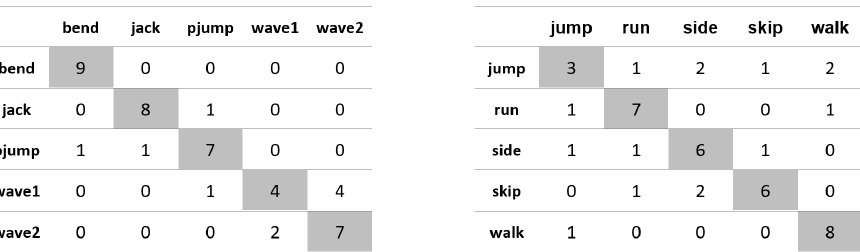
Figure A8. Confusion matrices for the experiment using the ‘lower-occlusion’ database, shorterMBR and Euclidean distance.